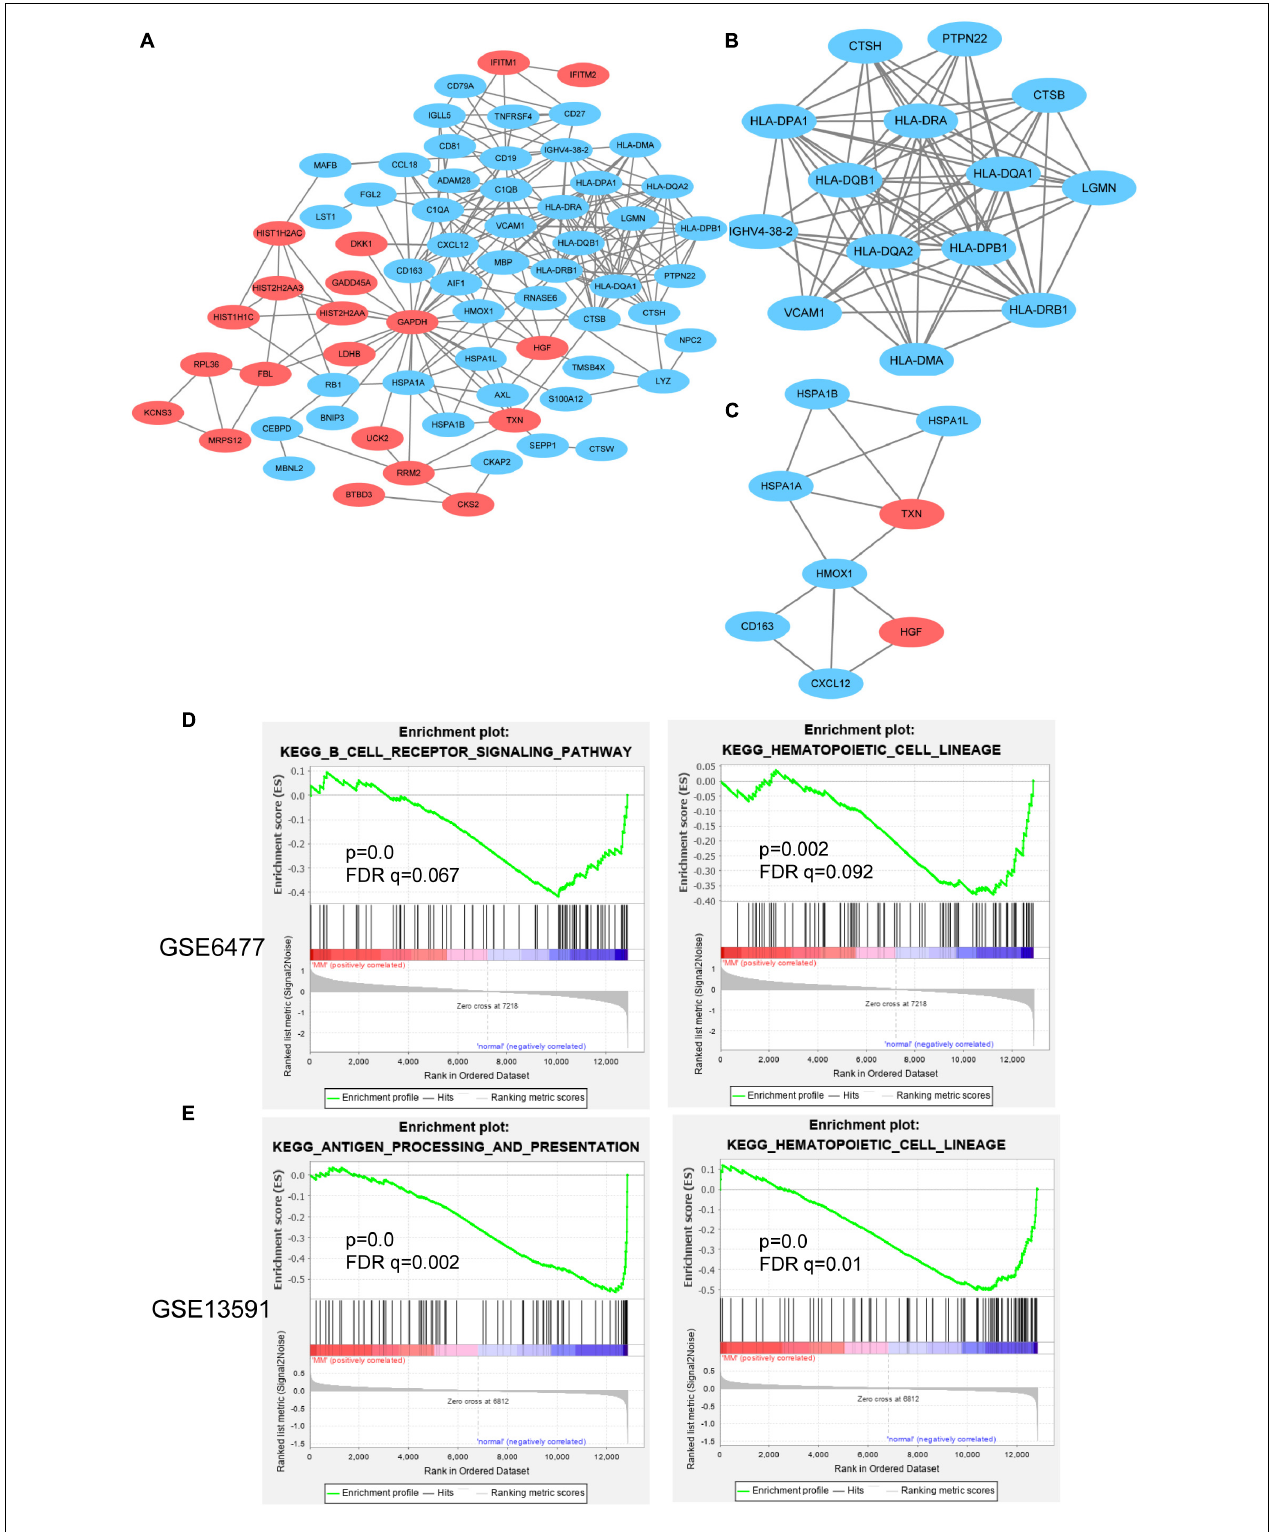
FIGURE 5 | PPI network and GSEA analysis for hub genes. (A) PPI network of DEGs contained down- and upregulated genes. Cluster analysis of PPI network in Cytotype MCODE: module 1 (B) and module 2 (C) . GSEA analysis of immune-related function in GSE6477 (D) and GSE13591 (E) .